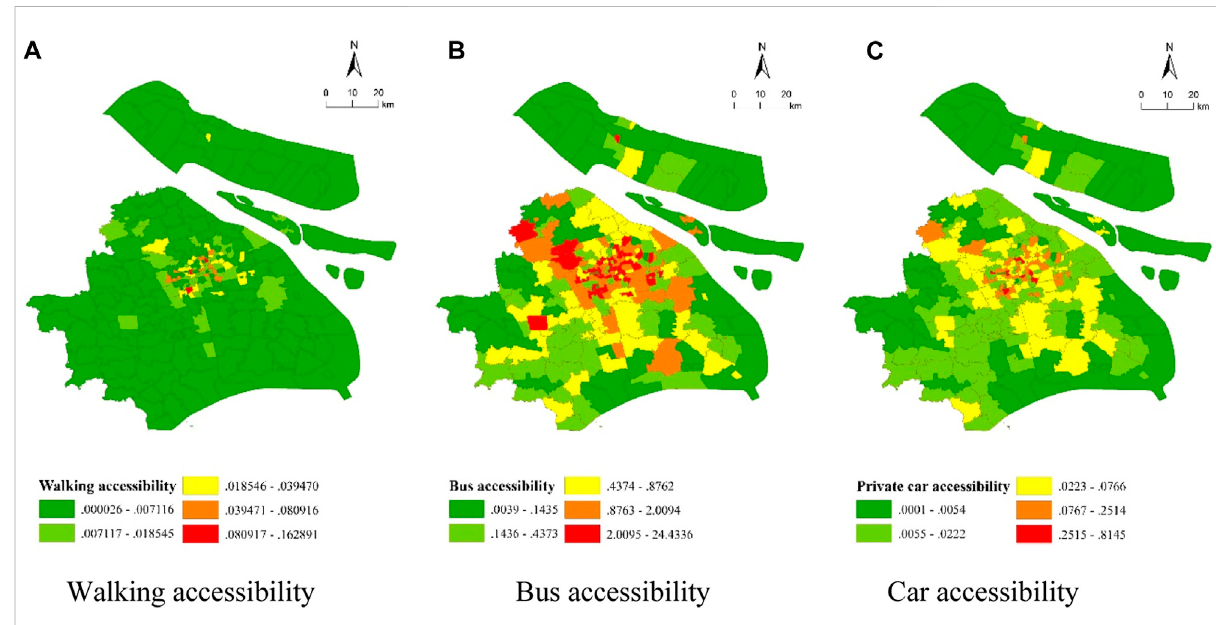
(Figure 4). In the case of Car travel, the proportion of street- town with moderate or higher accessibility reached 74.34%, which was higher than 59.42% of bus travel and 41.01%